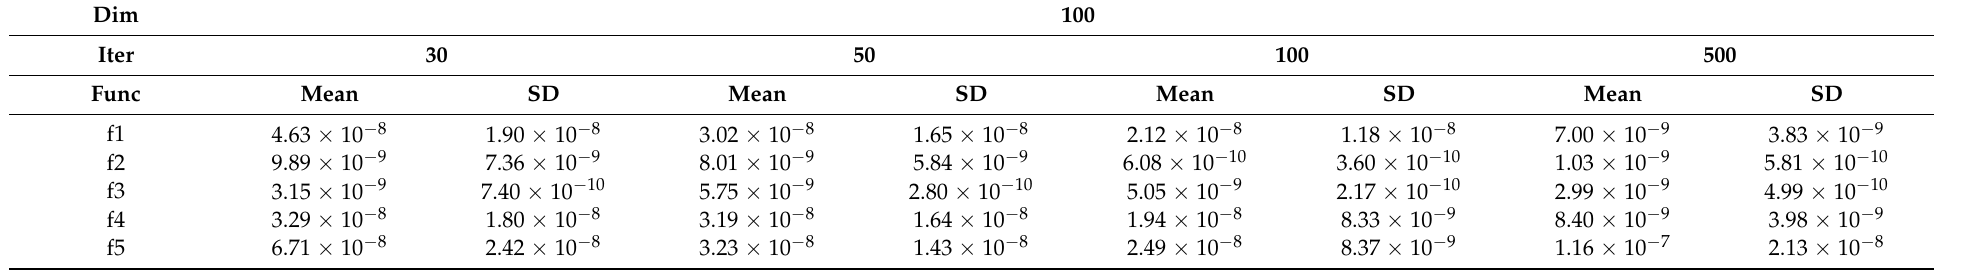
Table 6. MTOA: Results of the experiments for 100